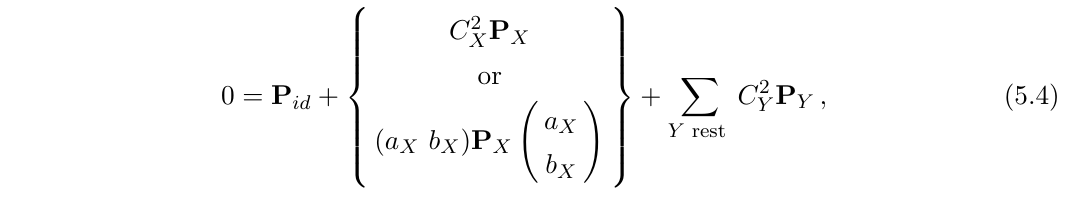
, (cid:1) , (cid:1) as a function of (cid:1) for (cid:3) = 10 ; 20 ; 30 ; 35 ; 40. [2 ; 0] [0 ; 2] [0 ; 1] [0 ; 0] = 1 [0 ; 0]